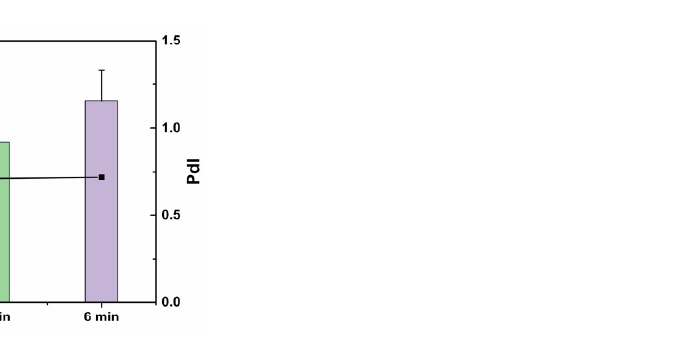
Figure 1. Particle size (column) and PDI (line) of MCM-41 nanoparticles with different ultrasonica- tion times.